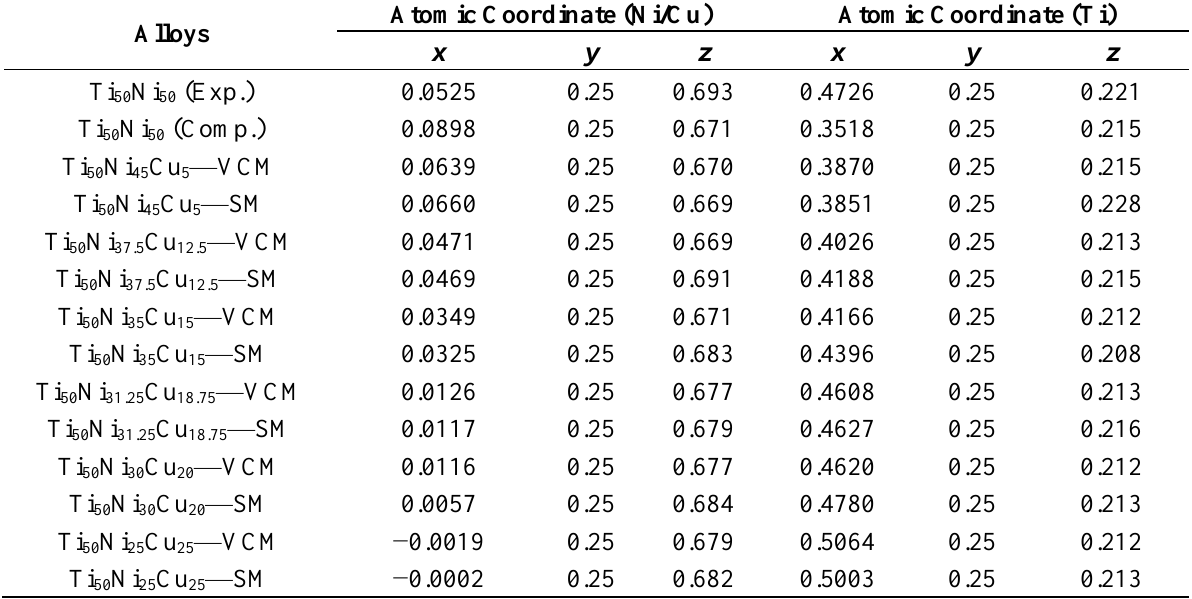
Table 2. Atomic coordinates ( x , y , z ) of Ti and Ni in TiNiCu alloys from Virtual Crystal Method (VCM) and Supercell Method